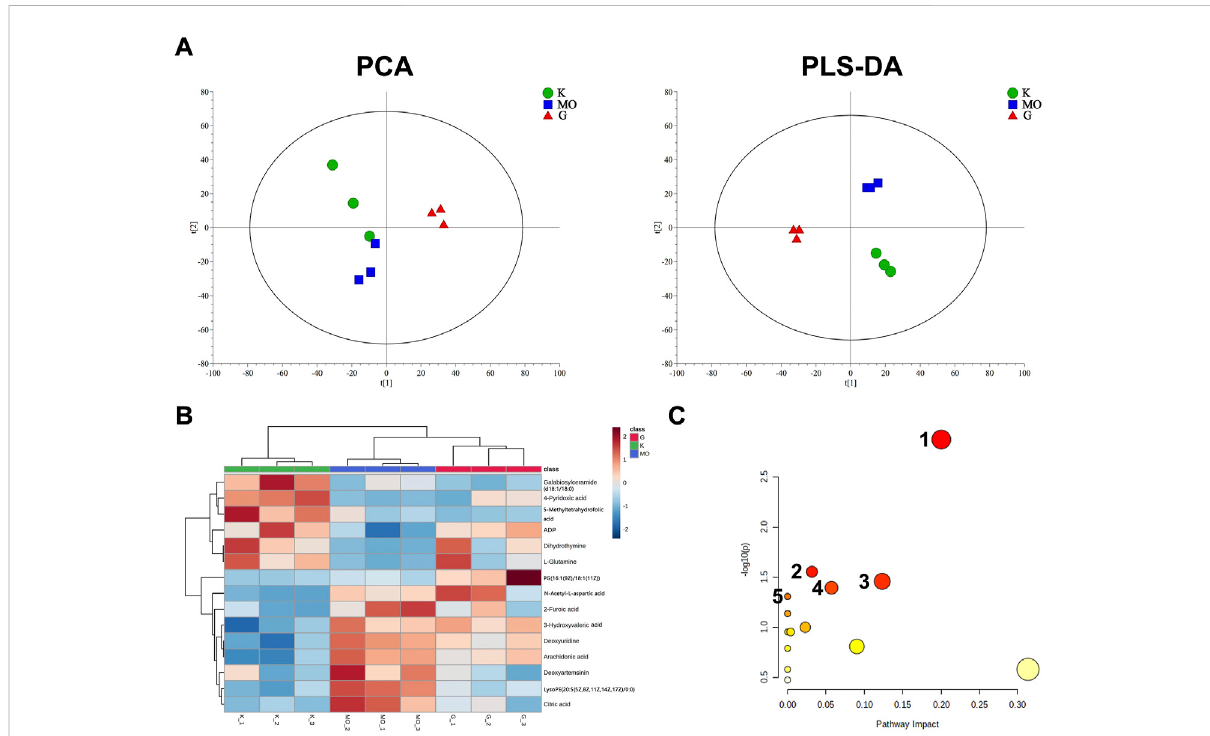
FIGURE 6 BLWE regulated different metabolites in the brain of APP/PS1 mice. Analysis of PCA and PLS-DA in brain tissue of mice. K denotes the control group; MO denotes the model group and G denotes the BLWE H-dose group (A) . Thermal map analysis of differential biomarkers. Metabolites markedinredrepresent up-regulated metabolites,while thosemarkedinbluerepresent down-regulatedmetabolites.Differentialmetaboliteswere displayed in each row, and single samples werelisted in each column (B) . n = 3 per group. Overview of BLWE-regulated metabolic pathways. 1, 2, 3, 4, and 5 refer to the alanine, aspartate and glutamate metabolism pathway, glyoxylate, and dicarboxylate metabolism pathway, glycerophospholipid metabolism pathway, pyrimidine metabolism pathway and D -glutamine and D -glutamate metabolism pathway, respectively (C)